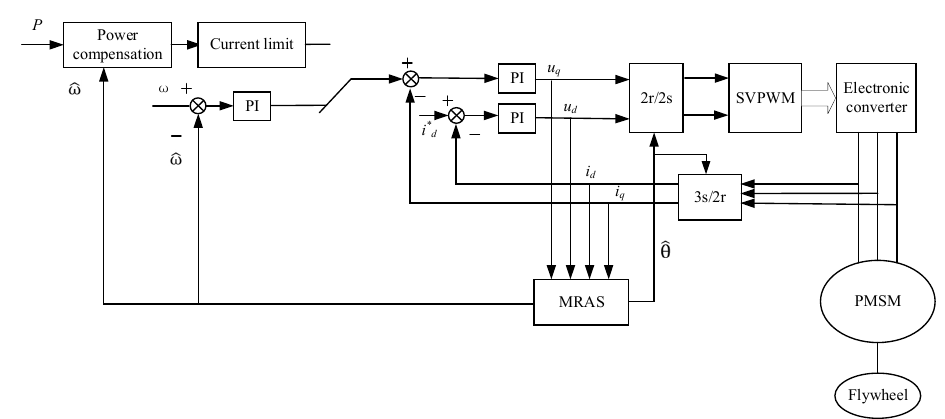
Figure 4. Wind power compensation flow chart.